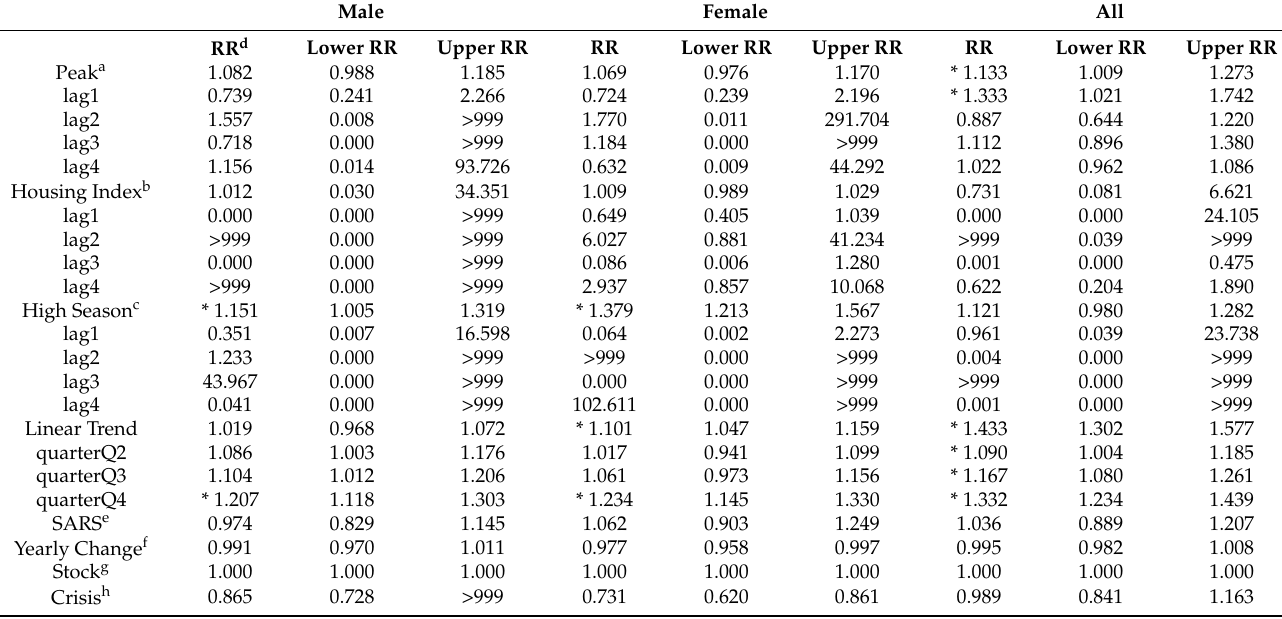
Table 2 presents the results for the association between the housing index and antide- pressant prescriptions. Among all recipients, a positive correlation was observed between the peak of housing prices and the number of prescriptions. The effect of the peak on the number of prescriptions was significant ( p < 0.05). Table 2. Distributed lag nonlinear model analysis of the housing market and mental disorder prevalence by